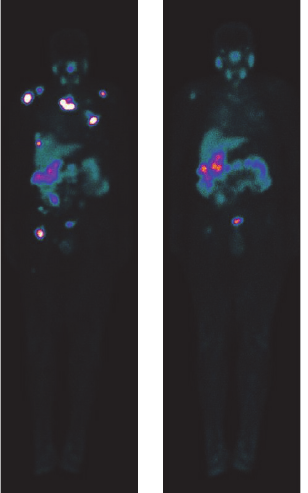
Figure 1: Anterior whole body 177 Lu-PSMA scan of a 72-year- old patient with metastasised castration-resistant prostate cancer. This demonstrates normal biodistribution in the nasal region, salivaryglands,liver,andspleengastrointestinalandurinarysystem, with multiple PSMA-avid metastases in the prostate bed, clavicle, sternum, clavicle, vertebrae, iliac bone, and femora. An excellent response to therapy was observed after 3 cycles of 177 Lu-PSMA-RLT with decrease in serum PSA level (from 63 to